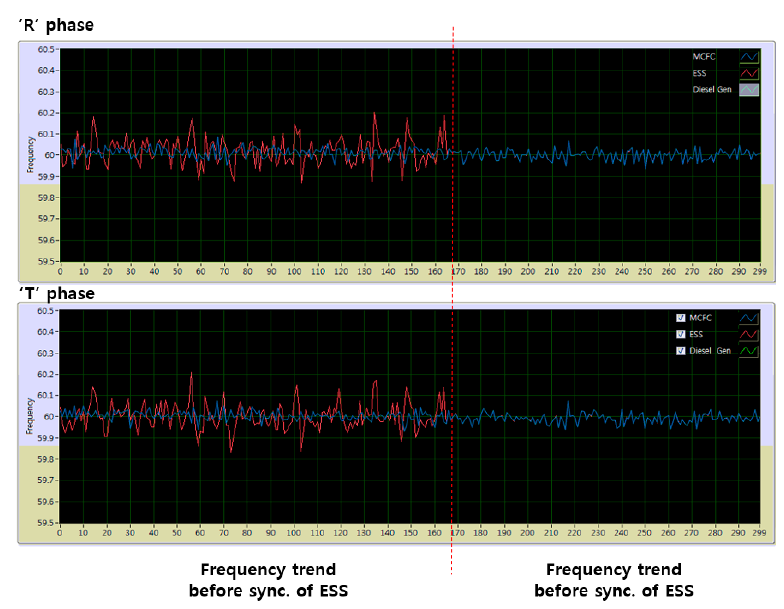
Figure 17. Frequency change during ESS synchronization.